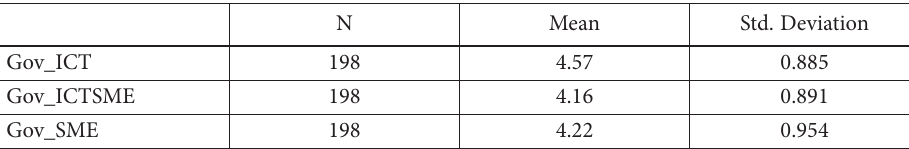
Table 2. Descriptive statistics for the variable government implication N Mean Std.